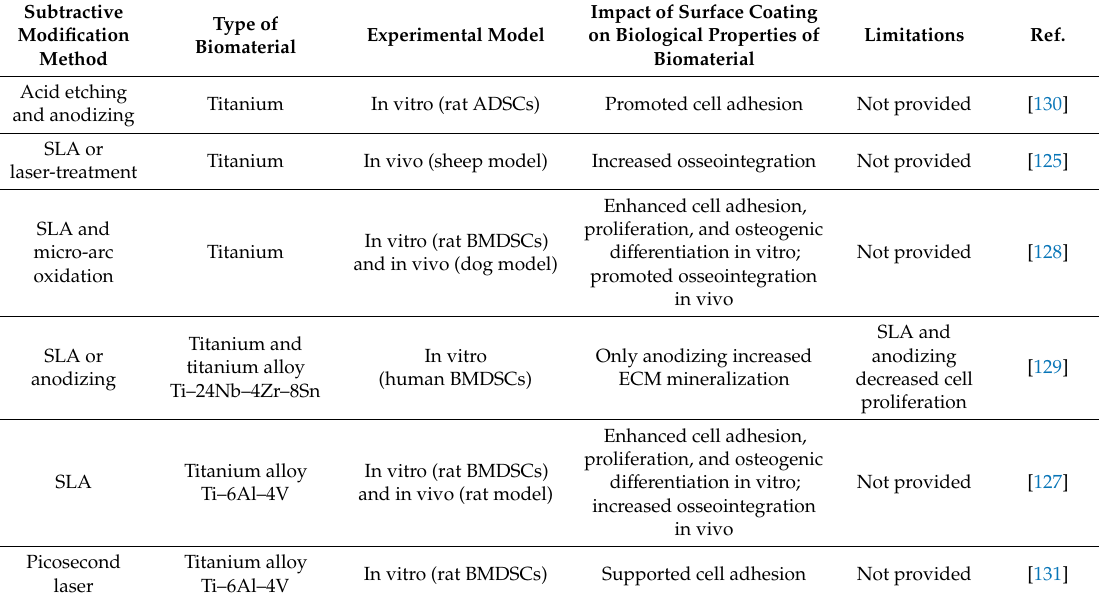
Table 4. Subtractive surface modifications of